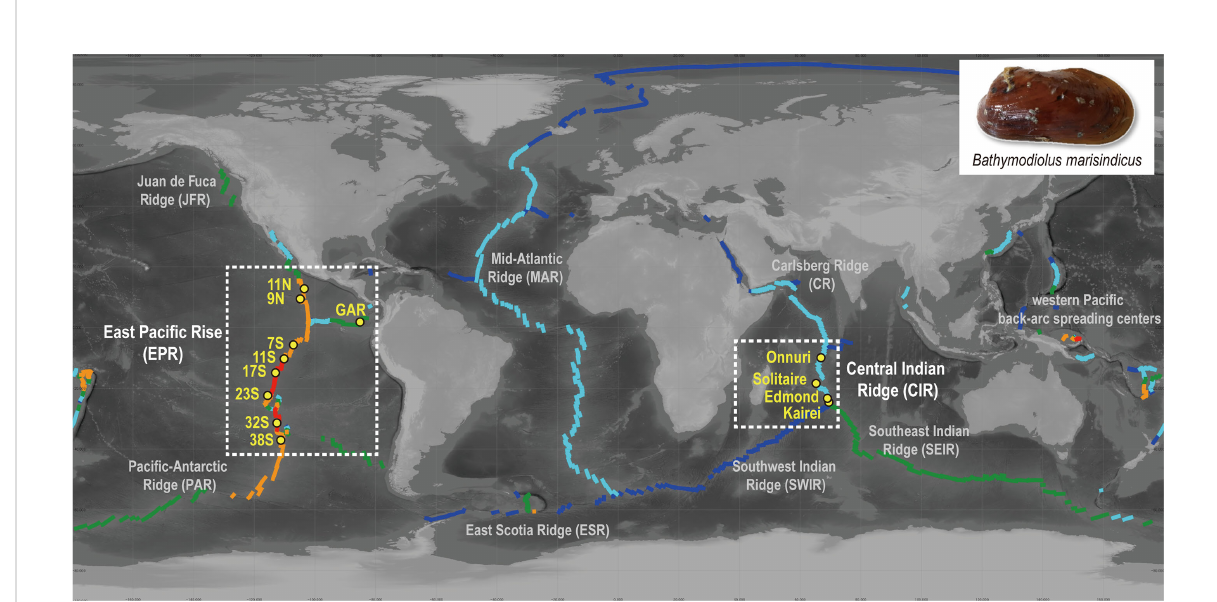
FIGURE 1 Distribution of sampling sites in this study and spreading rate of ridge axes. The colors of the ridge axes represent their spreading rate (Bird, 2003): ultra-slow (dark blue, <20 mm/year), slow (light blue, 20 – 50 mm/year), intermediate (green, 50 – 80 mm/year), fast (orange, 30 – 140 mm/ year), and superfast (red, >140 mm/year). Map created with QGIS v. 3.12.3 using bathymetry data from the General Bathymetric Chart of the Oceans